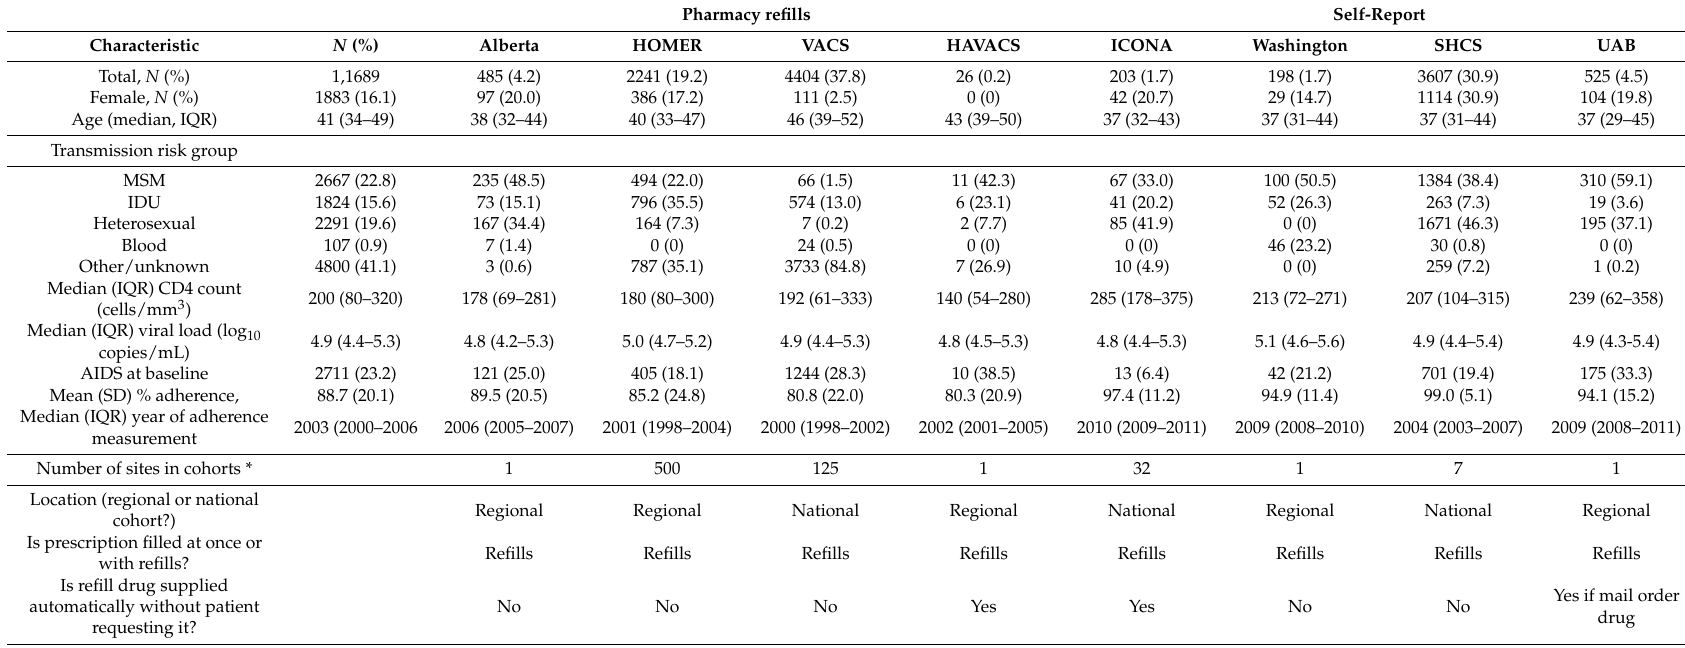
Table 1. Baseline patient and cohort characteristics, N =